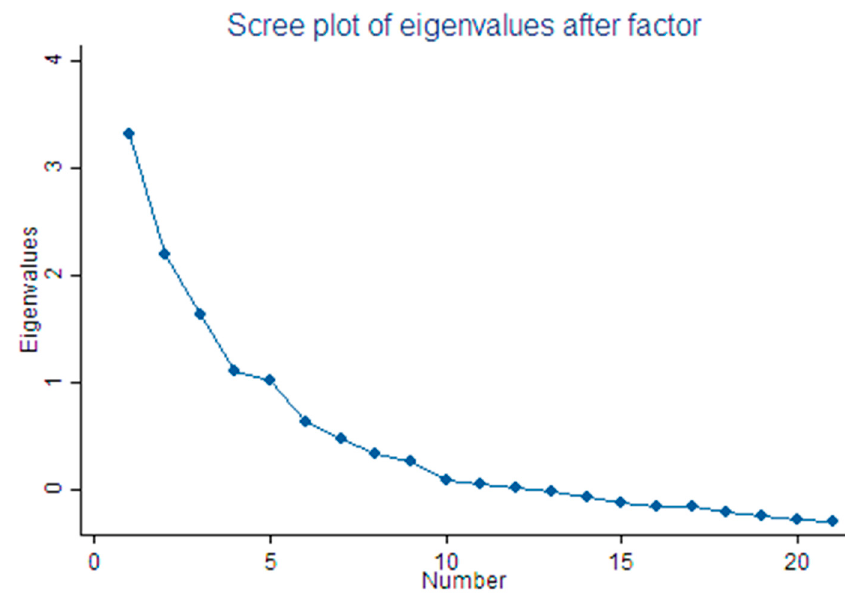
Figure 1. Scree plot of the eigenvalues and the number of factors. Table 3. Factor Loadings * from Exploratory Factor Analysis (N = 110).